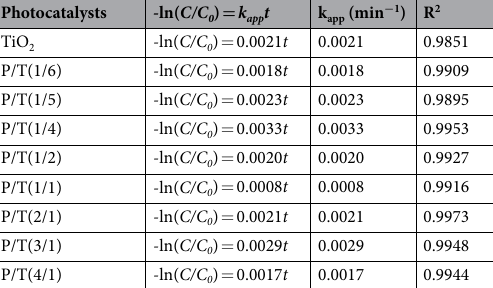
Table 2. Apparent first-order rate constants ( k app ) of MB degradation and linear regression coefficients from a plot of -ln( C/C